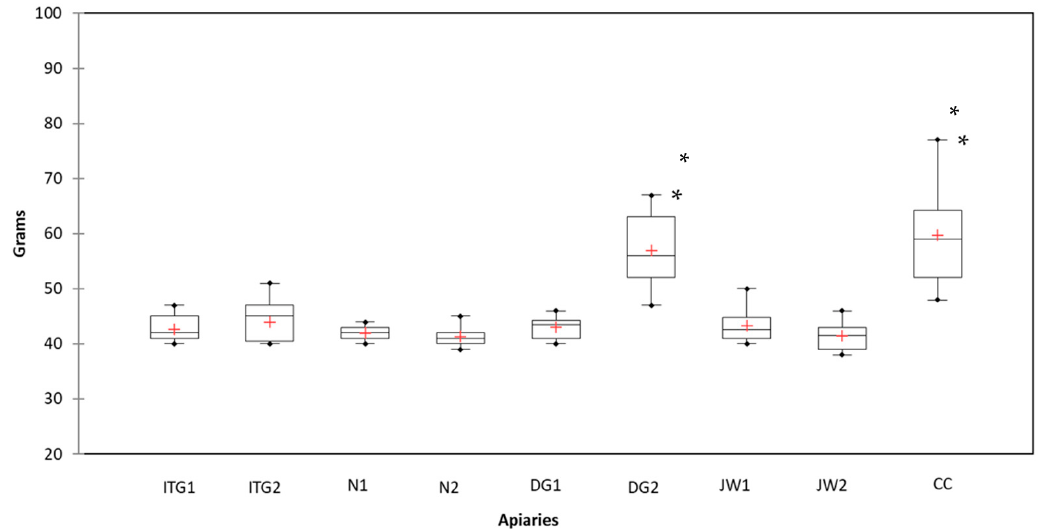
Figure 2. Weights of collected samples of adult bees in the different apiaries. * p < 0.0001; Bonferroni corrected significance level: 0.0018.